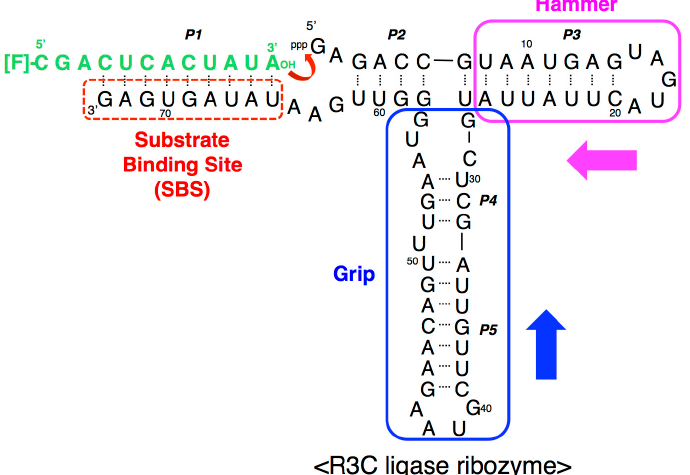
Figure 1. Composition of the R3C ligase ribozyme with a fluorescence-labeled RNA substrate. The ribozyme is composed of 73 nucleotides and forms five paired regions (P1–P5). The stem-loop region comprising P3 was designated as the “hammer”, and the region comprising P4 and P5 was designated as the “grip” (see above). R3C ribozyme has a single-stranded substrate-binding site (SBS) at the 3 ′ -terminal region. In a previous study [12], we created a smaller R3C variant (~50 nucleotides) which still retained greater than 10% activity of full-length R3C by shortening both the “hammer” and “grip” [12]. The numbering of the nucleotides starts from the guanosine triphosphate at the 5 ′ -end.